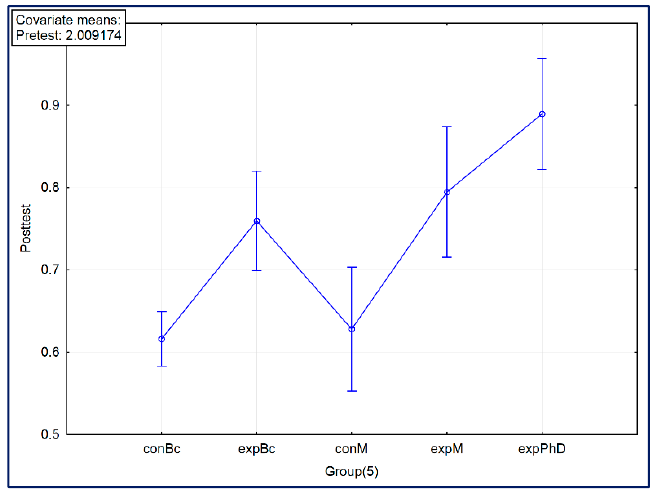
Figure 7. Graph of point and interval estimation of the mean for the posttest with the pretest control, taking into account the degree of study. Table 9. Multiple comparisons taking into account the degree of study. Group